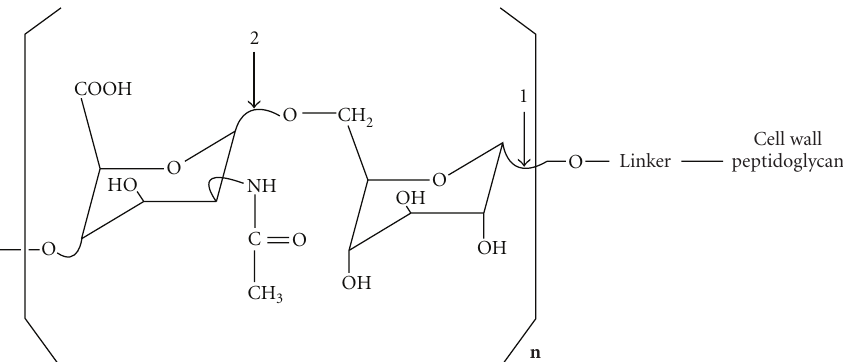
Figure 1: Chemical structure of teichuronic acid in the cell wall of Micrococcus luteus and proposed site of action for glucosyltransferase (indicated by arrow 1) and that for ManNAcA transferase (indicated by arrow 2). The linker contains an oligosaccharide with a GlcNAc residue at the reducing end and a phosphate.